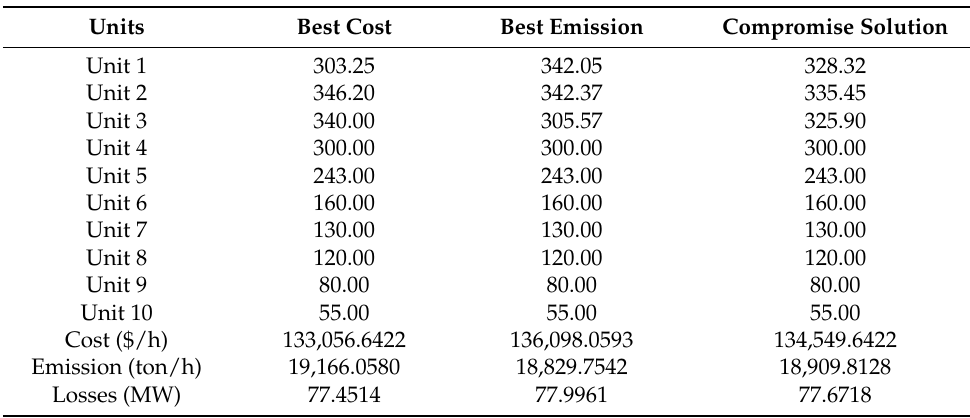
Table 2. Optimal power dispatch in MW for case 1.